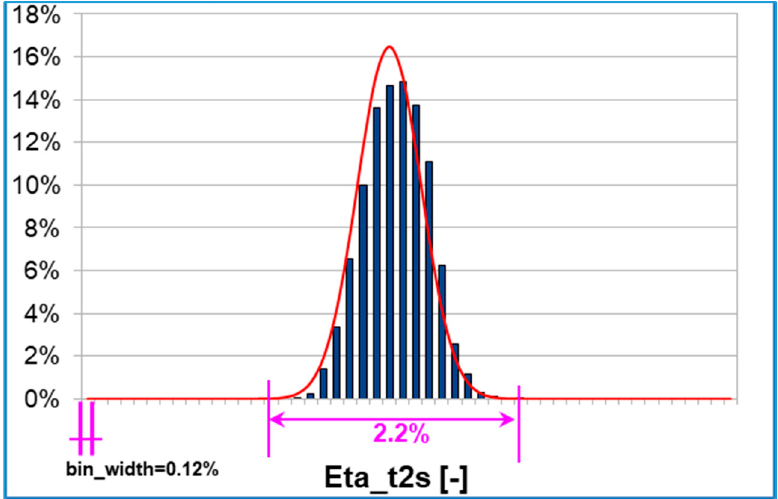
Figure 6. SB-UQ: overall efficiency probability bars (in blue) and related Gaussian trend (red line).